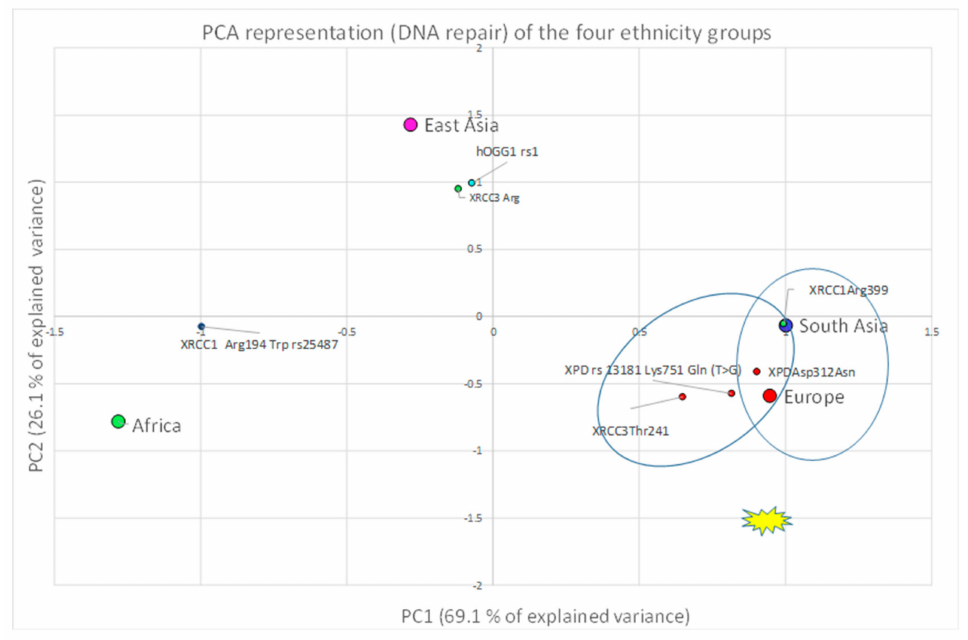
Figure 7. Europe and South Asia show a high correlation and high susceptibility risk with their DNA repair